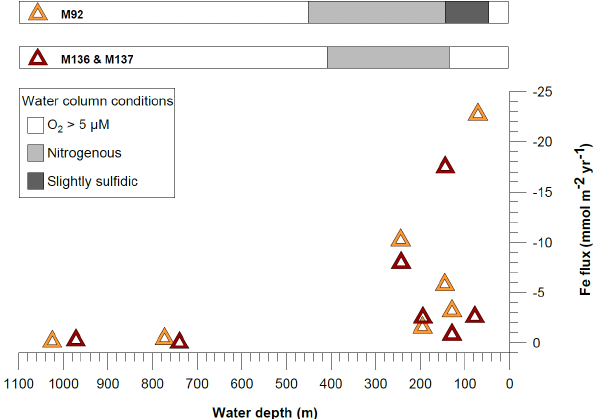
Figure 9. Comparison of benthic diffusive Fe(II) fluxes between cruises M136–M137 and M92 (data from Schroller-Lomnitz et al., 2019) on the Peruvian shelf. Negative values represent fluxes from the sediment pore water into the bottom waters. The shaded bars above the panel display the geochemical conditions in the water column during the time of